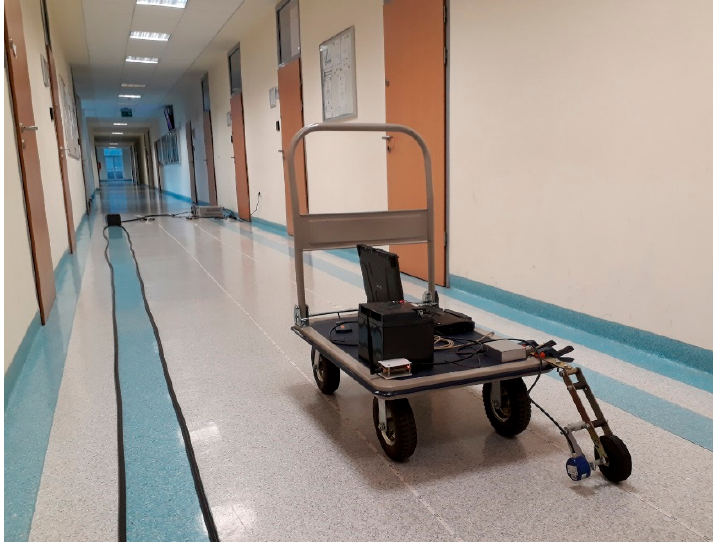
Figure 8. Measurement setup in the scenario with two feeders and frequency conversion.